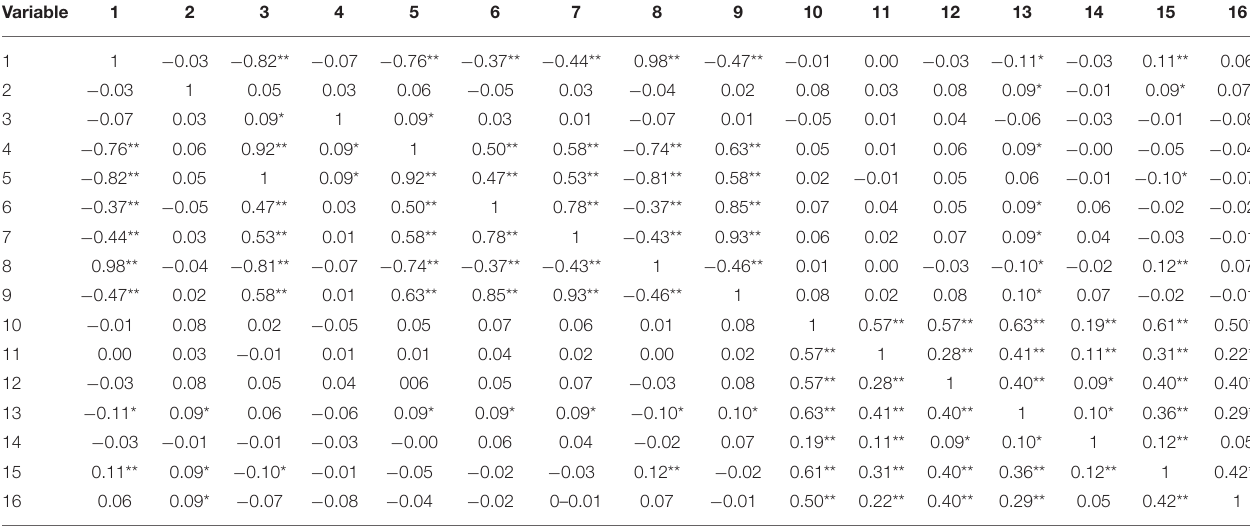
TABLE 4 | Pearson correlation coefficient of satisfaction of postpartum mothers with study variables.